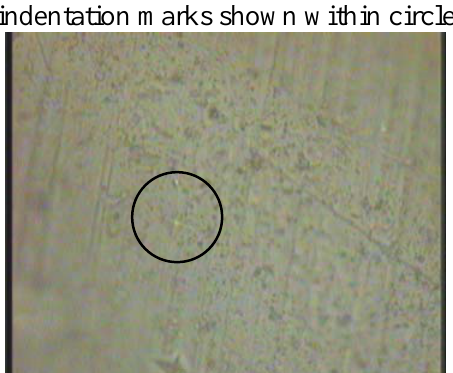
Figure 12. Hardness test for the specimen with highest hardness. H = 28 GPa. (indentation marks shown within